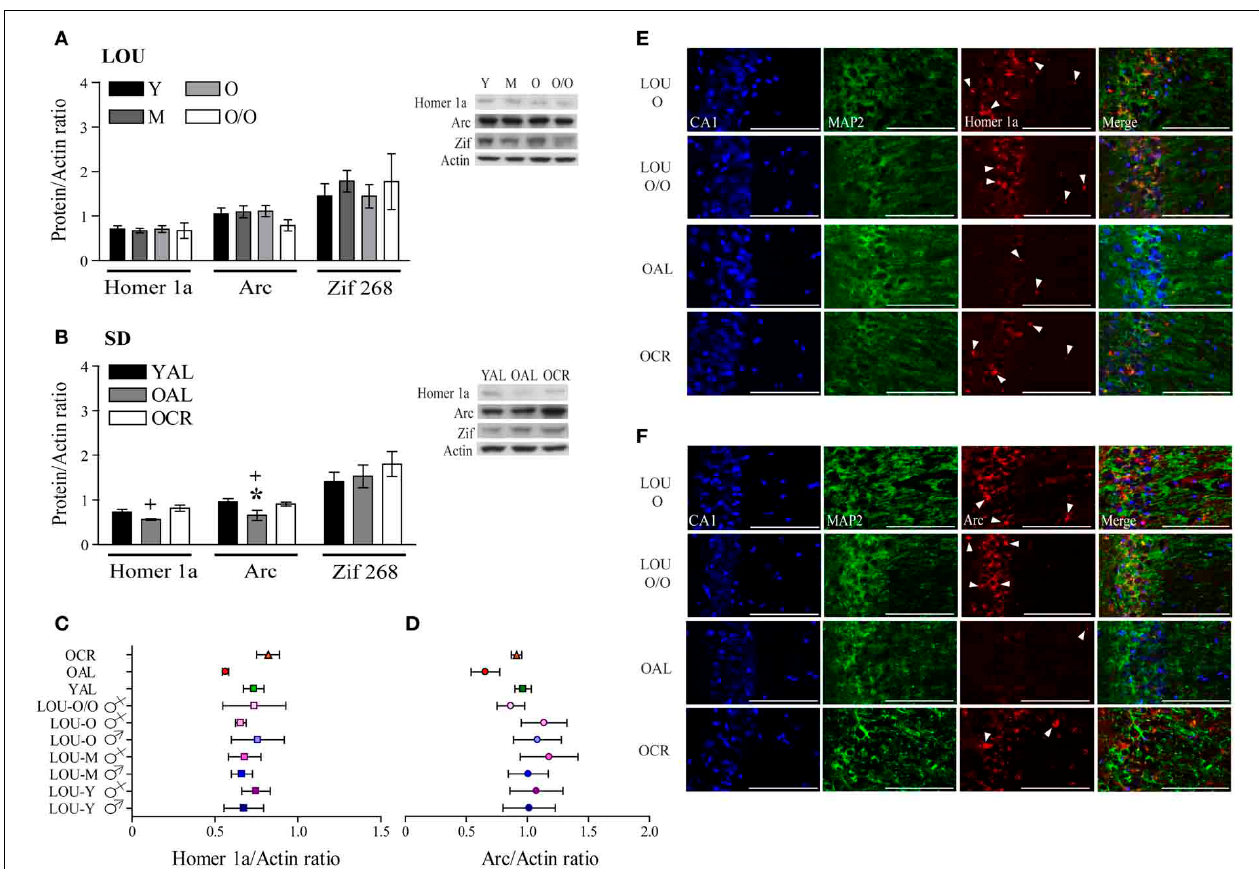
FIGURE 8 | Immediate early genes Homer 1a and Arc protein levels are maintained in the hippocampal formation of O and O/O LOU and OCR SD rats. (A) In line with intact cognition and youthful levels of glutamate receptors, Homer 1a, Arc, and Zif 268 expression remained unchanged in aging LOU rats after MWM reactivation. (B) Conversely, both Homer 1a and Arc expression was decreased in old AL memory-impaired SD rats, in comparison to OCR rats which are characterized by intact recognition memory and spatial learning acquisition. Representative blots of IEG protein levels and actin loading control are shown for each rat group. Comparison of IEG protein levels between all rat groups is shown for Homer 1a (C) and Arc (D) . (E)